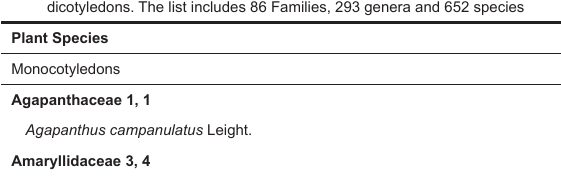
TABLE 4 Comprehensive list of Angiosperms, listed first by monocotyledons and then dicotyledons. The list includes 86 Families, 293 genera and 652 species